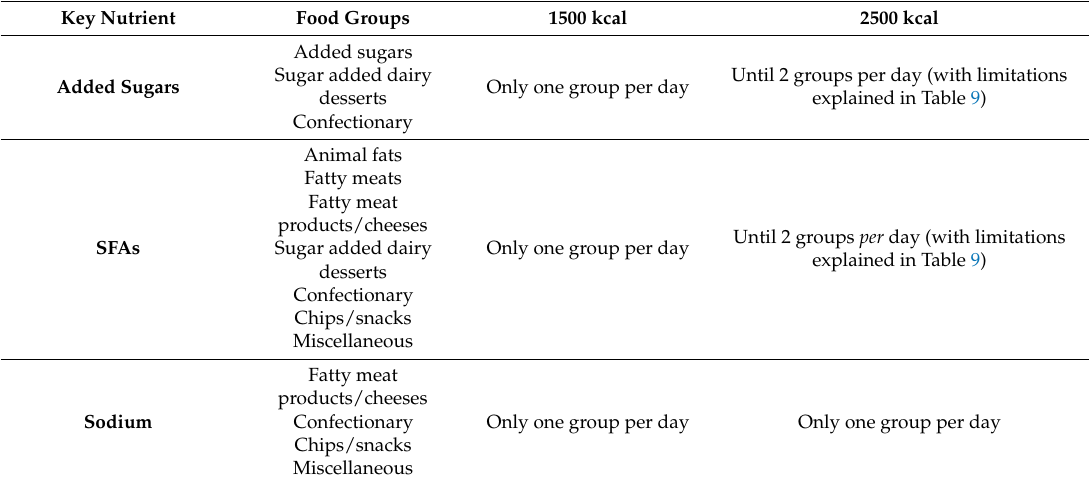
Table 8. Food groups with control in the simultaneous consumption in a day and concerning nutrient per group. Guides for two caloric